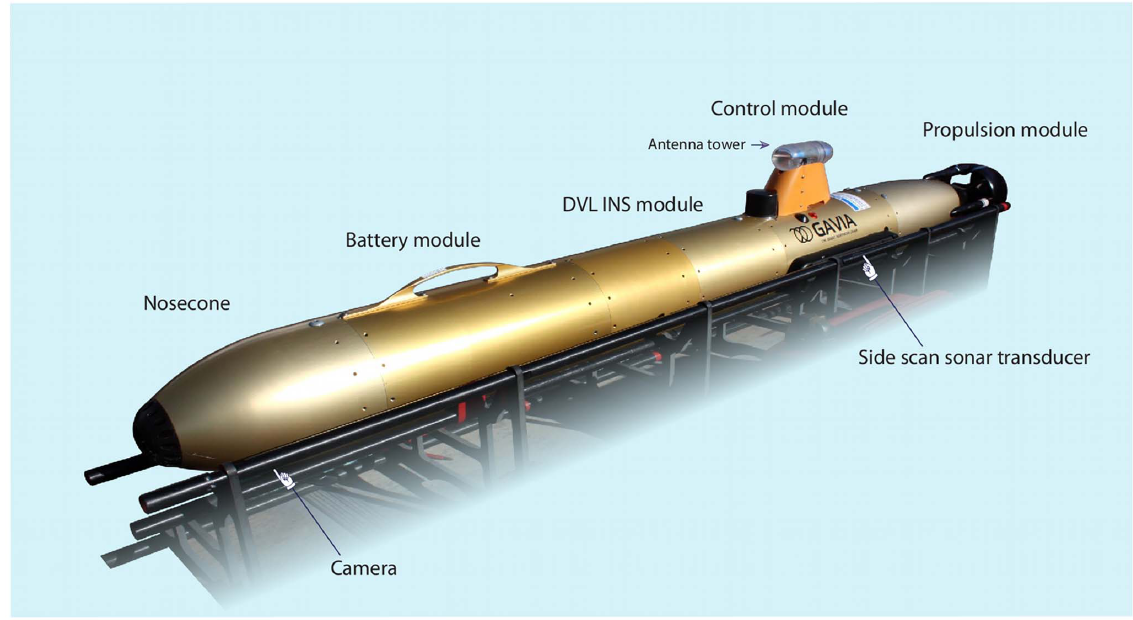
Figure 1. The Gavia autonomous underwater vehicle used for this study. Modules include nosecone with camera, battery module, doppler velocity log, control unit with tower and side-scan sonar, and propulsion module. The strobe is located under the control module.